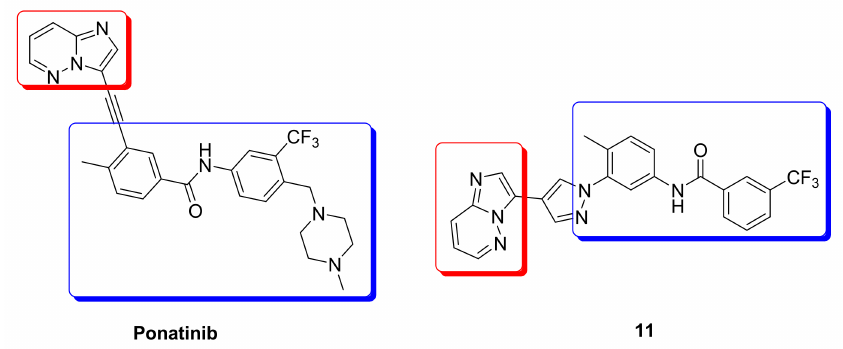
Figure 21. Modifications to ponatinib structure leading to compound 11 .